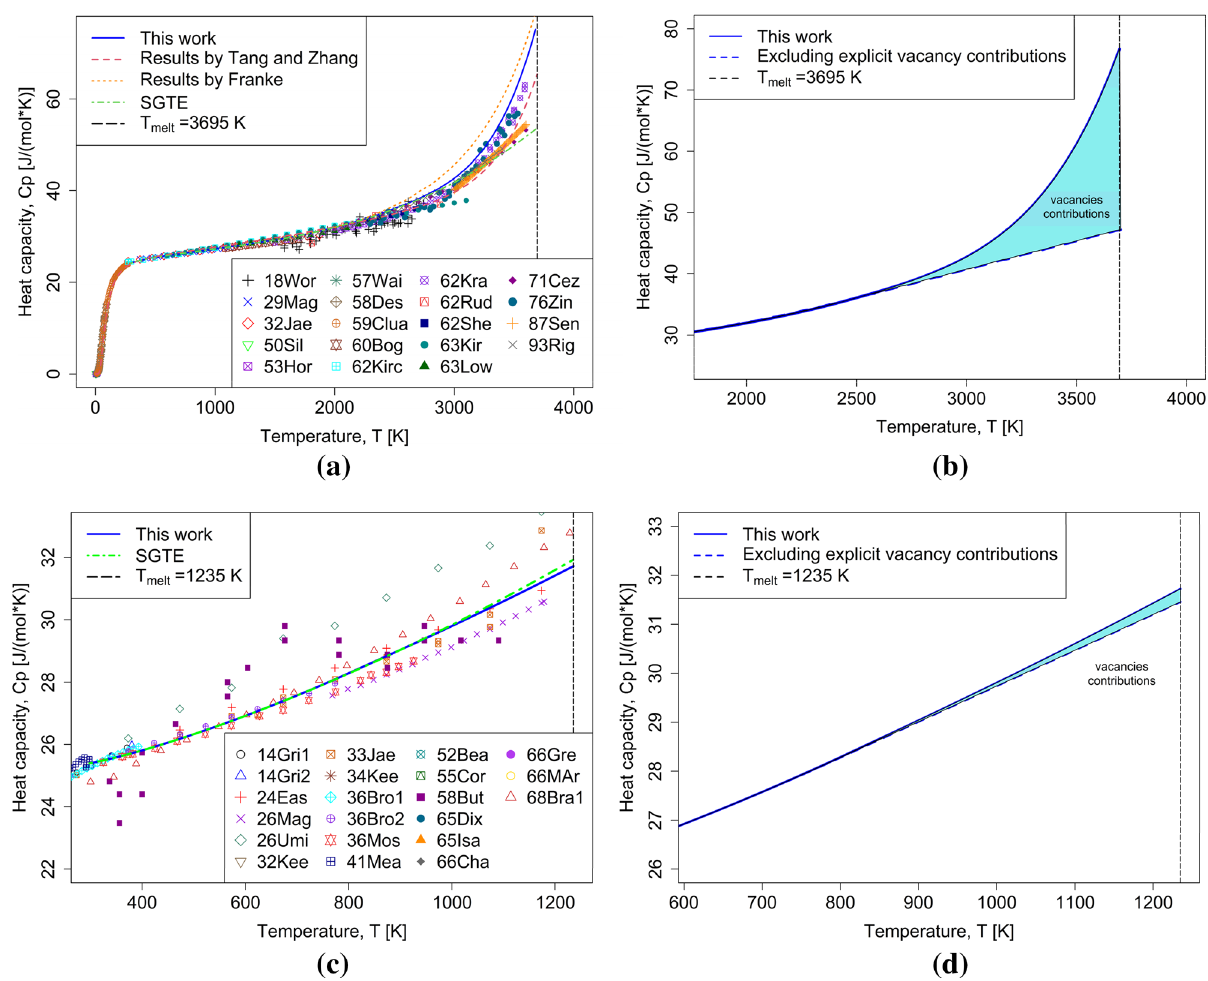
Figure 6. Proposed model heat capacity results for ( a ) BCC-W compared to results from Tang and Zhang 21 , Franke 20 and SGTE 44 and experimental data ( b ) vacancy contribution added by proposed model for BCC-W ( c ) FCC-Ag compared to results from SGTE44 and experimental data ( d ) vacancy contribution added by proposed model for FCC-Ag.